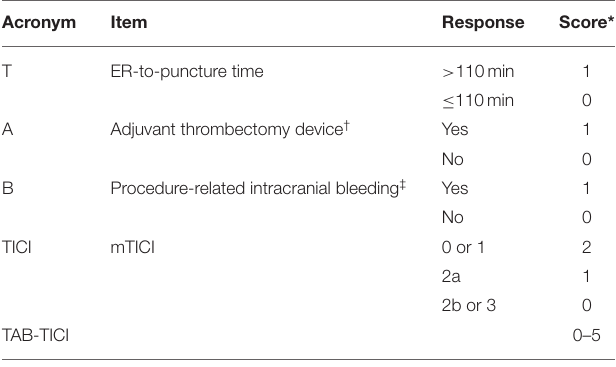
TABLE 4 | Components of the TAB-TICI score.